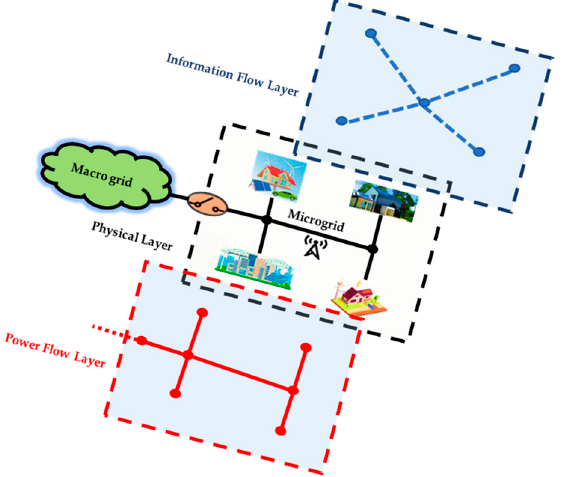
Figure 5. Different layers of a microgrid.